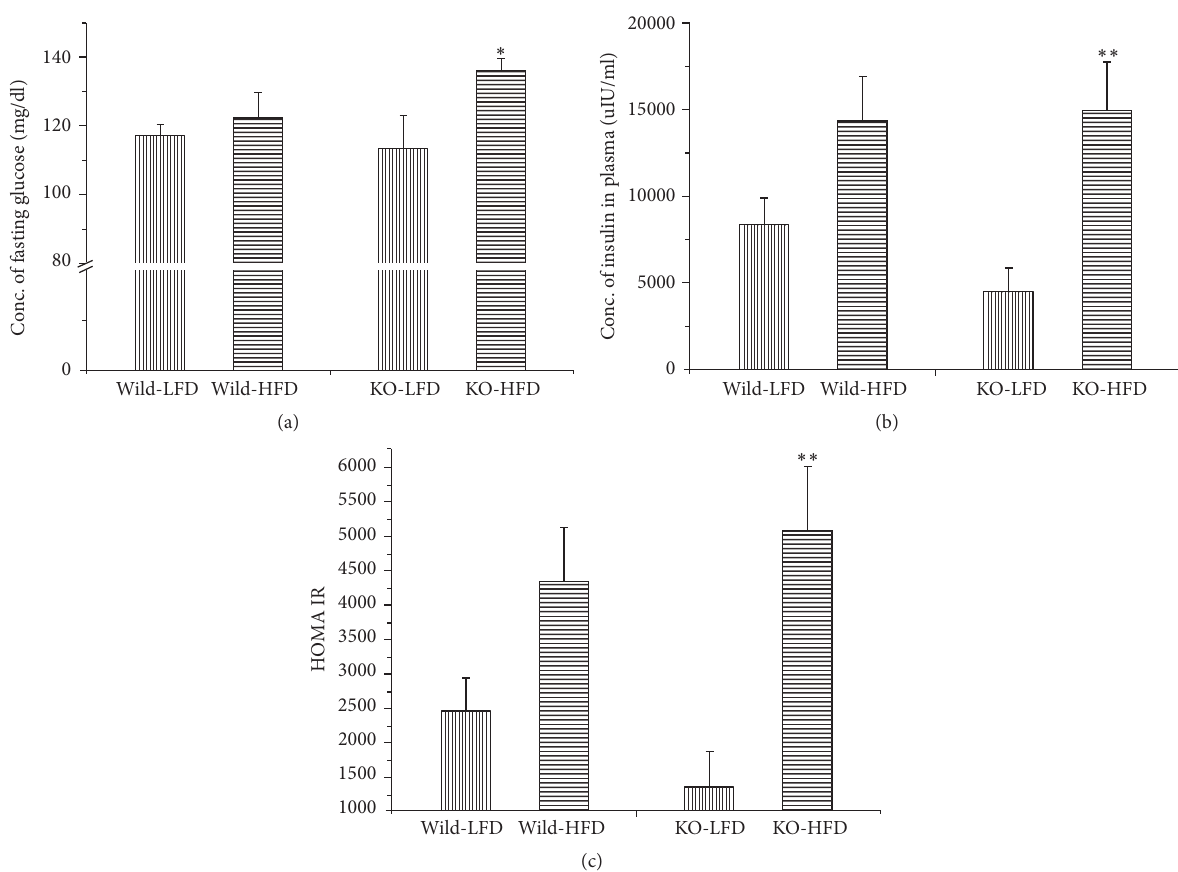
Figure 3: Insulin resistance index in the Mig-6 f/f and Mig-6 d/d mice. (a) Fasting plasma glucose concentration. (b) Fasting plasma insulin concentration. (c) HOMA-IR index. The fasting plasma concentration of glucose and insulin were measured at 25 weeks of age. ∗ and ∗∗ indicate 𝑃 < 0.05 and 𝑃 < 0.01 versus LFD treated group in the same genotype, respectively.